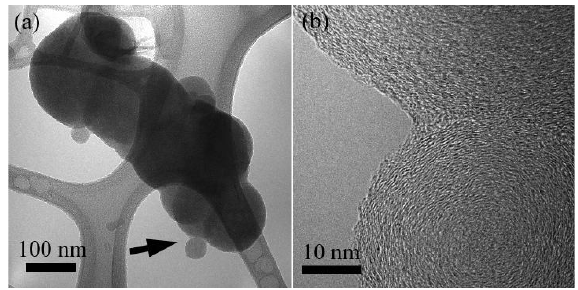
Figure 11. TEM image (a) of large spherule soot from 120 m, and HRTEM image (b) from2 Fig. 11. TEM image (a) of large spherule soot from 120 m, and the area indicated by arrow.3 HRTEM image (b) from the area indicated by arrow. 4